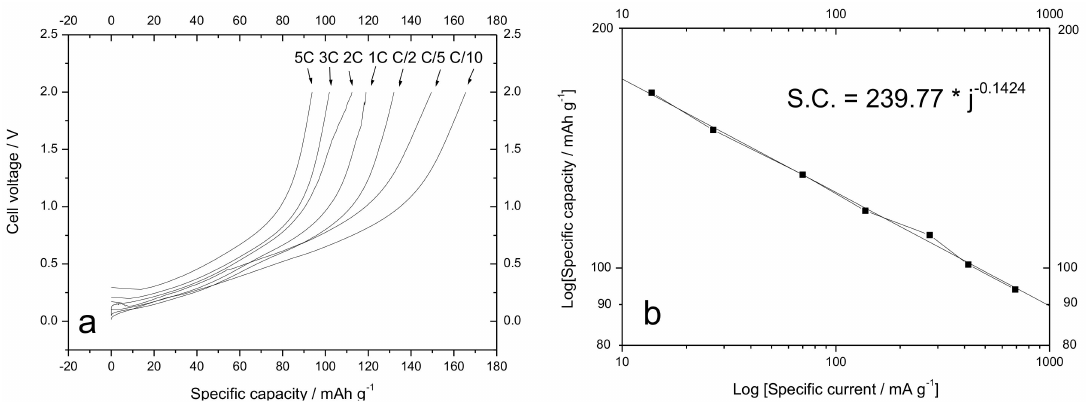
Figure 8. Differential capacity recorded during the first three cycles for the Sn-RGO-based electrode.